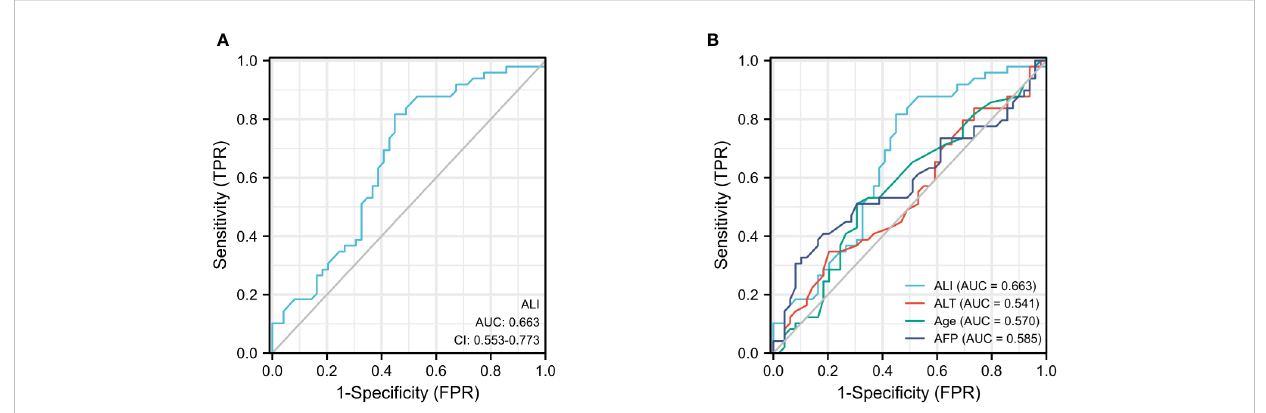
FIGURE 1 The ROC curves for ALI (A) , AFP, ALT, and age (B) in advanced hepatocellular carcinoma